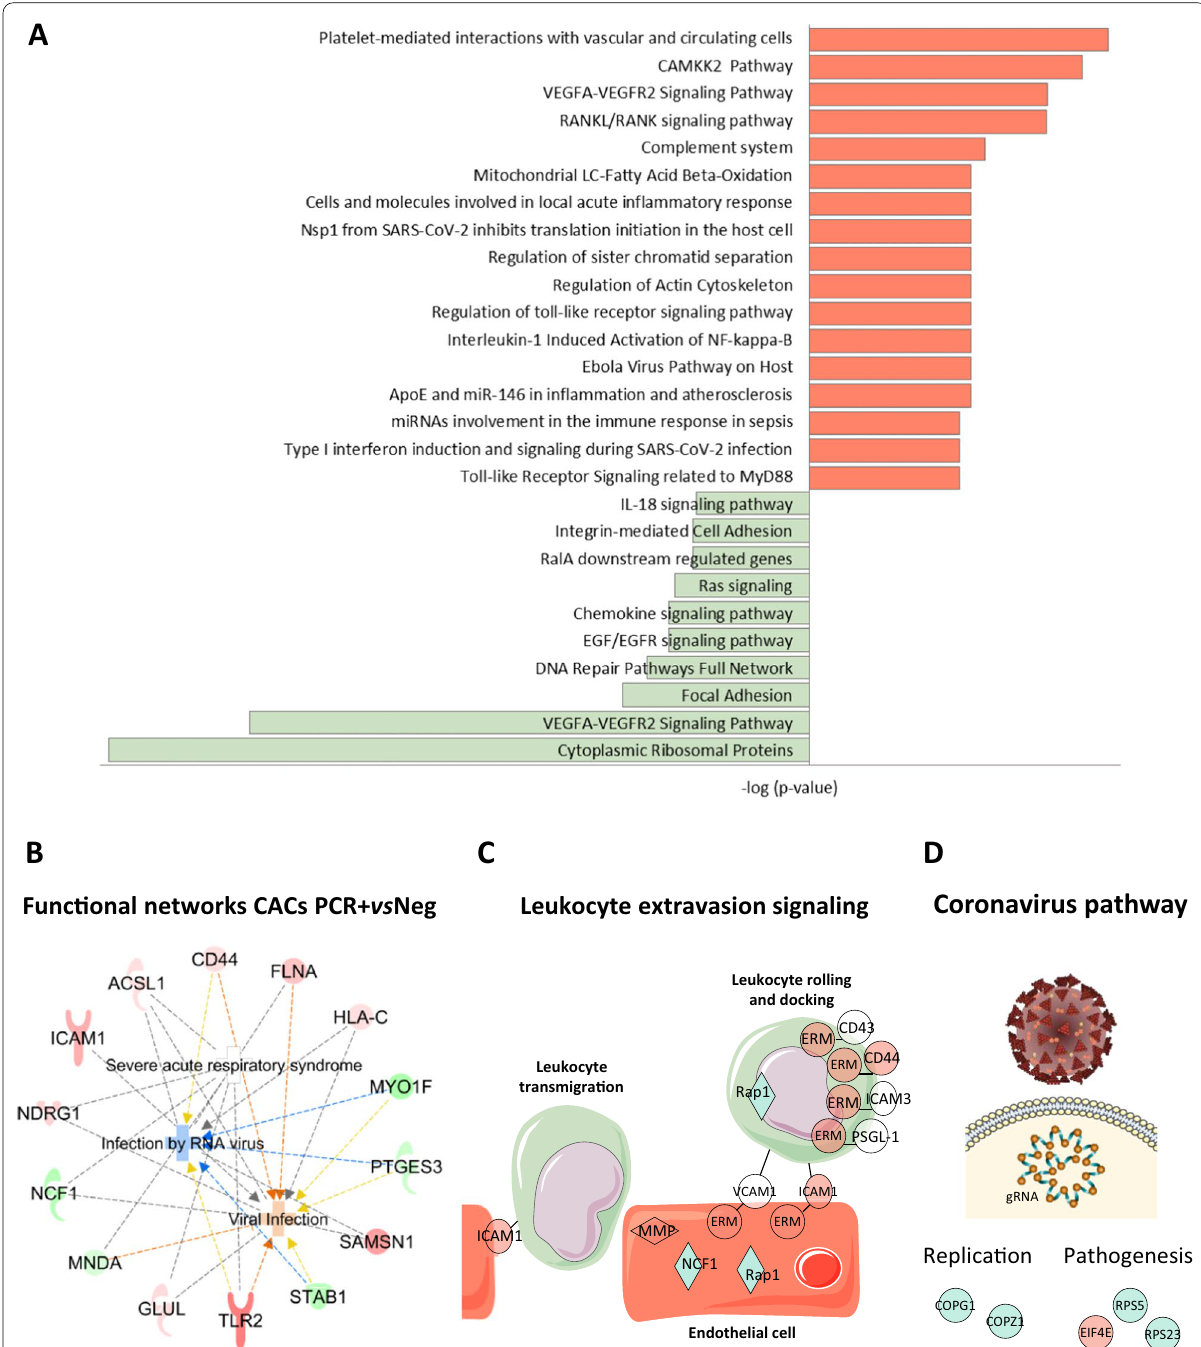
Fig. 5 Functional classification of proteomic changes in CACs treated with the serum of PCR vs Neg donors. A Altered pathways related with + up‑ (red) and down‑ (green) regulated proteins in CACs PCR vs CACs Neg. B Ingenuity (IPA) functional network with proteins up‑ (red) or + + down‑regulated (green) in CACs PCR vs CACs Neg, correlated with viral infection and severe acute respiratory syndrome (SARS), among others. + + C IPA graphical representation of proteins altered in CACs incubated with the serum of COVID‑19 PCR patients, compared to negative controls, + participating in leukocyte extravasation signaling. D Proteins altered in CACs IgG vs CACs Neg related to viral pathogenesis and + +